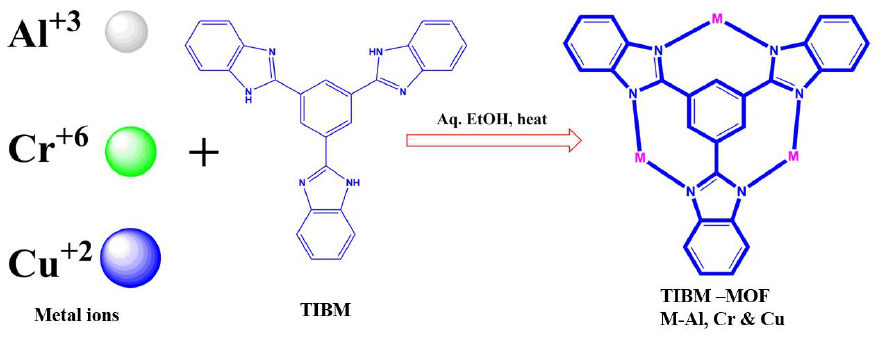
Figure 10. Synthesis of TIBM-MOFs (i.e., M= Al, Cr, and